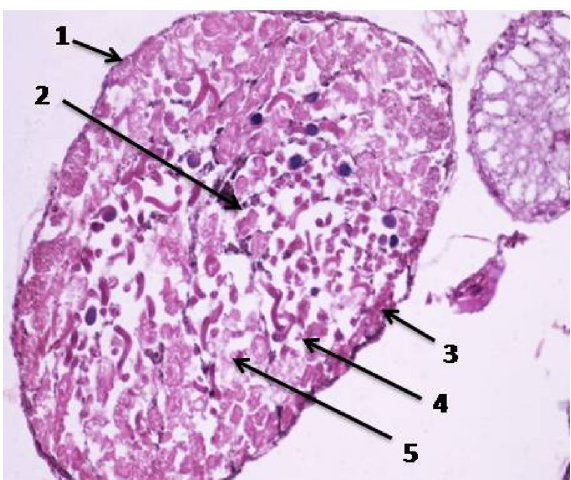
Figure 4. Cross section in the testis of unirradiated male Ephestia cautella (×400). 1, Testicular wall; 2, spermatogonia; 3, spermatids; 4, primary spermatocyte; 5, secondary spermatocyte.